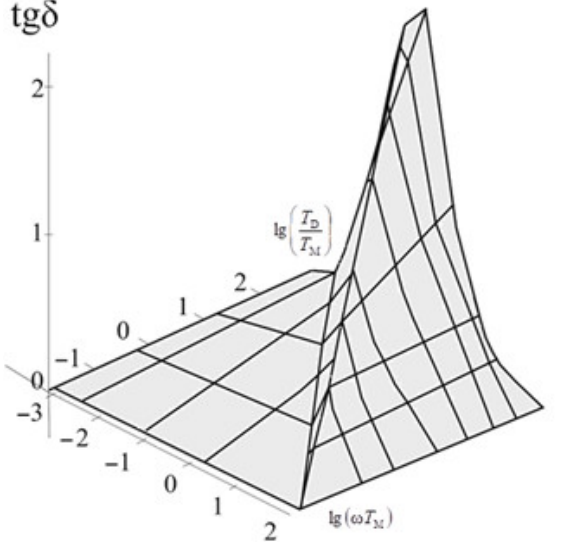
(cid:104) (cid:16) (cid:17)(cid:105) T D tg δ ( ω ) ; ω T M on dimensionless parame- T M M